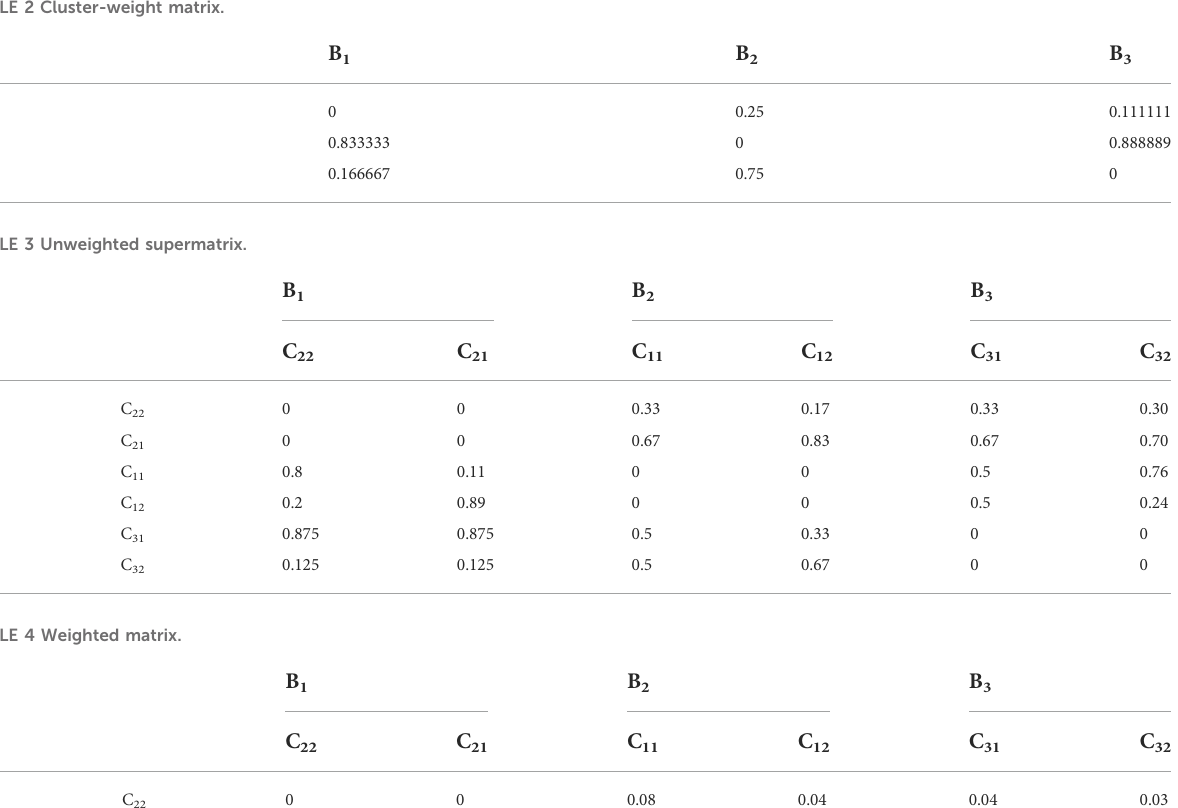
TABLE 2 Cluster-weight matrix.